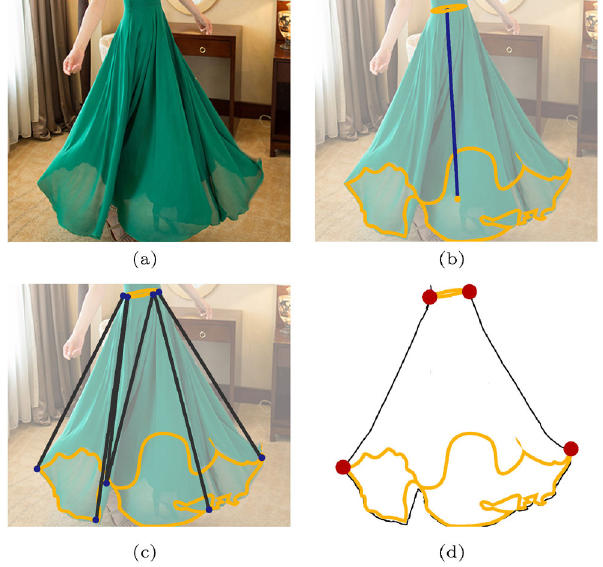
Fig. 2 User input. (a) Original image. (b) User sketched curves representing cross sections (shown in yellow) and the main axis (shown in blue). (c) Point correspondences between sections, with the related points shown in blue and their connections shown in dark gray. (d) Manually assigned boundary points (in red) show where the input curves meet the shape silhouette in the